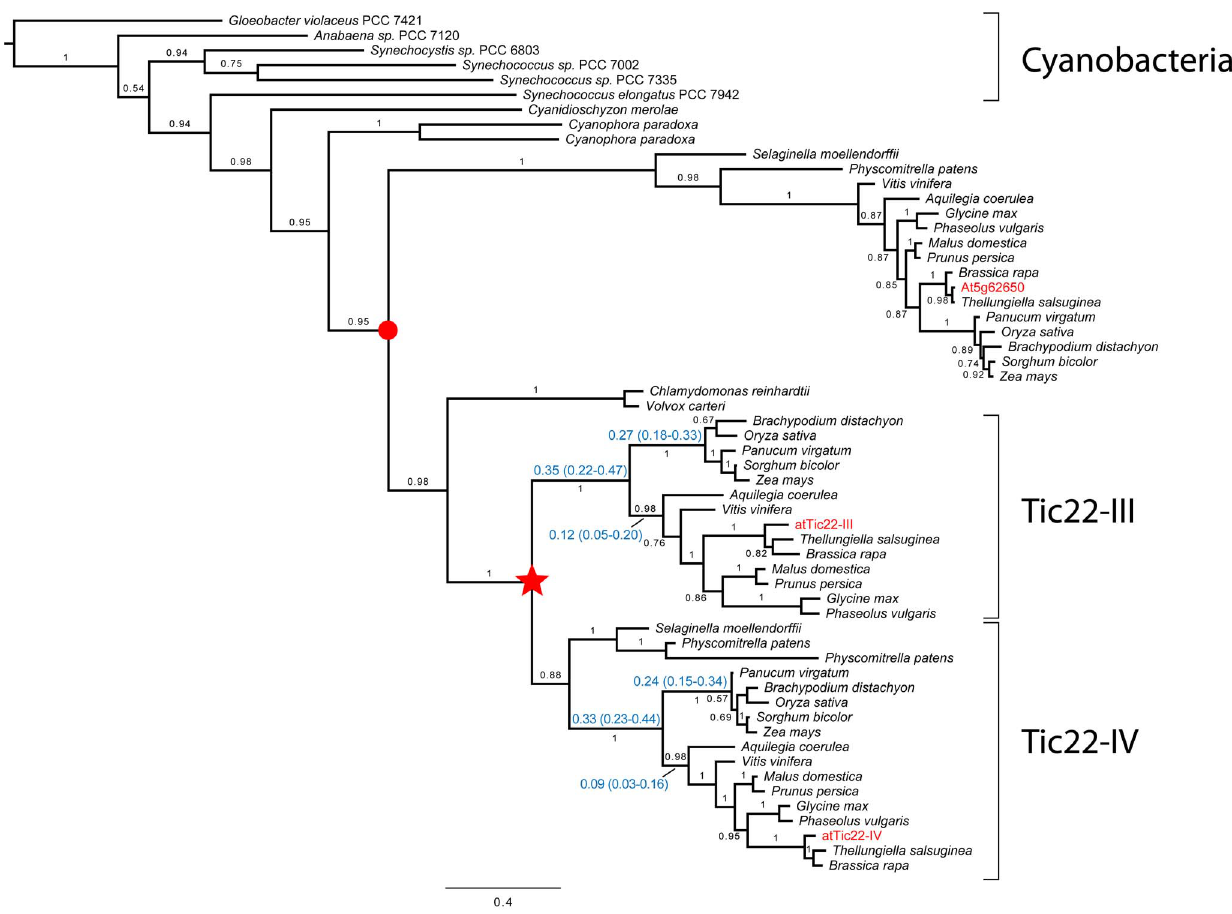
Figure 1. Phylogenetic analysis of the Tic22 gene family in plants and cyanobacteria. Homologous sequences identified in whole genome sequence datasets from plants and cyanobacteria were analysed using the program MrBayes. The analysis showed a strong support for an origin of Tic22 in cyanobacteria, and revealed that all investigated plant and algal species include at least one member of the gene family. A gene duplication occurred at least 416–449 million years ago (indicated by a star), and resulted in two paralogous gene copies that have been conserved in all investigated angiosperms. Branch lengths in the two clades formed by the gene duplication are very similar (mean branch length and the 95% Highest Posterior Density [HPD] credibility interval are shown for a selection of branches), which indicates that the evolutionary rates of the two paralogous copies have been similar over an extensive period of time. A partial gene duplication (indicated with a red dot) is inferred to have happened after the split between red algae and other archaeplastida. The partially-duplicated gene of unknown function has been conserved in all investigated land plant species, but has not been found in any algal species. All Arabidopsis sequences are shown in red text. Posterior probability values appear above the branches, and the expected number of changes per site along the branches is indicated by the scale